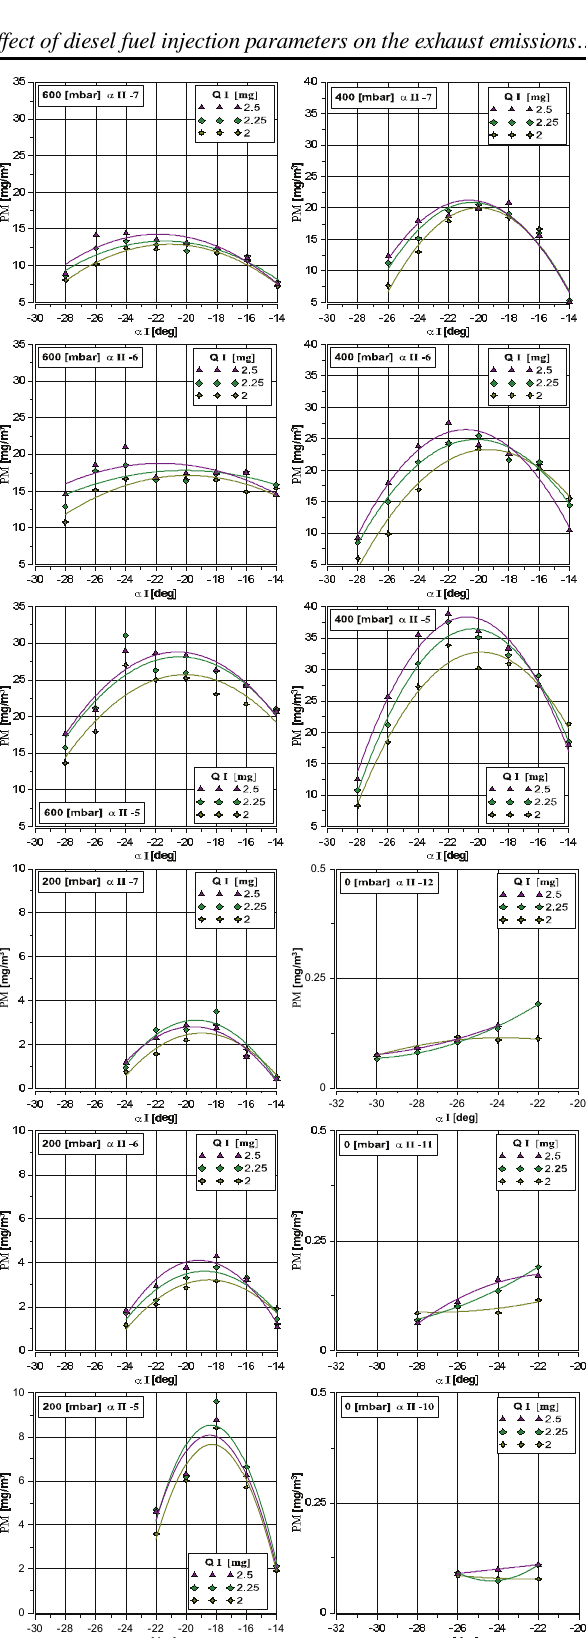
Fig. 4. Characteristics of variability of particulate matter (PM) content in exhaust for different injection parameters of diesel fuel dose initiating